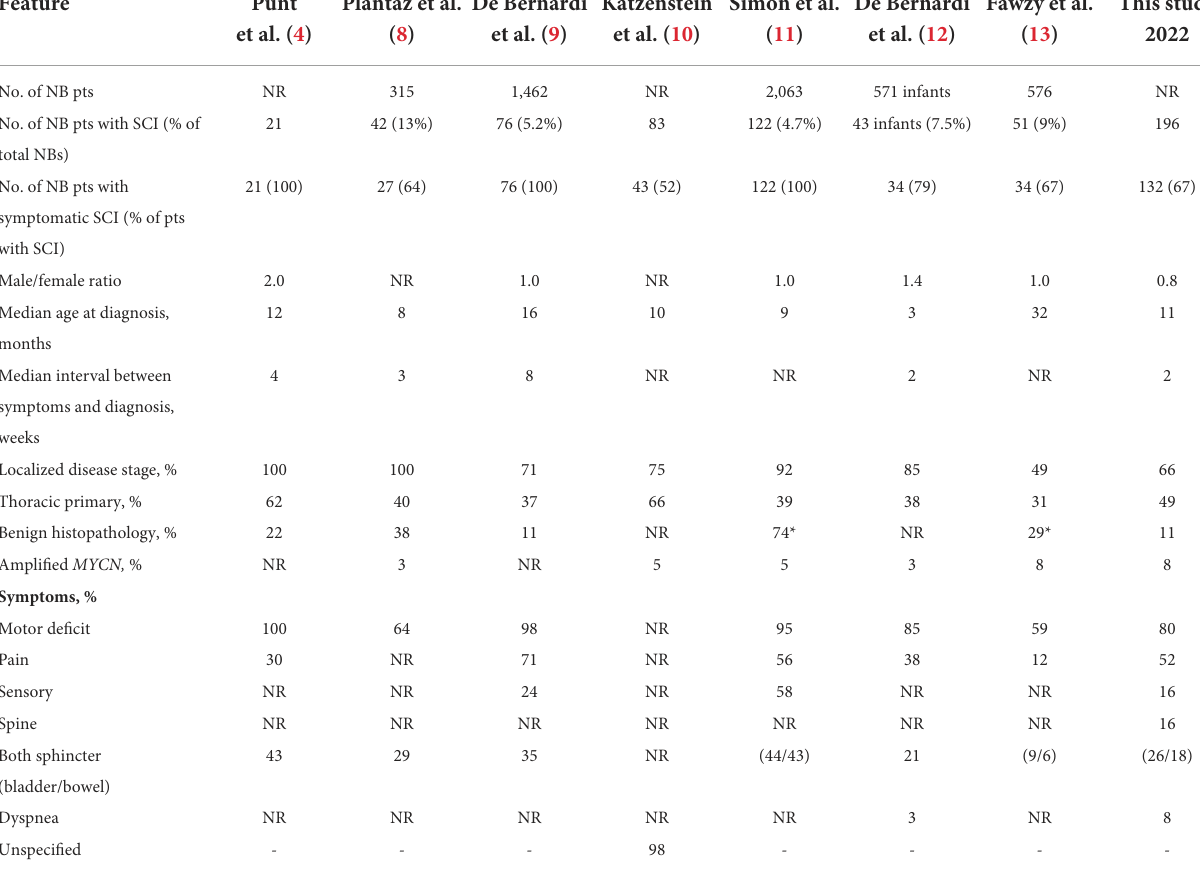
TABLE 7 Presenting features of children enrolled in the NB-SCI study in comparison with previous